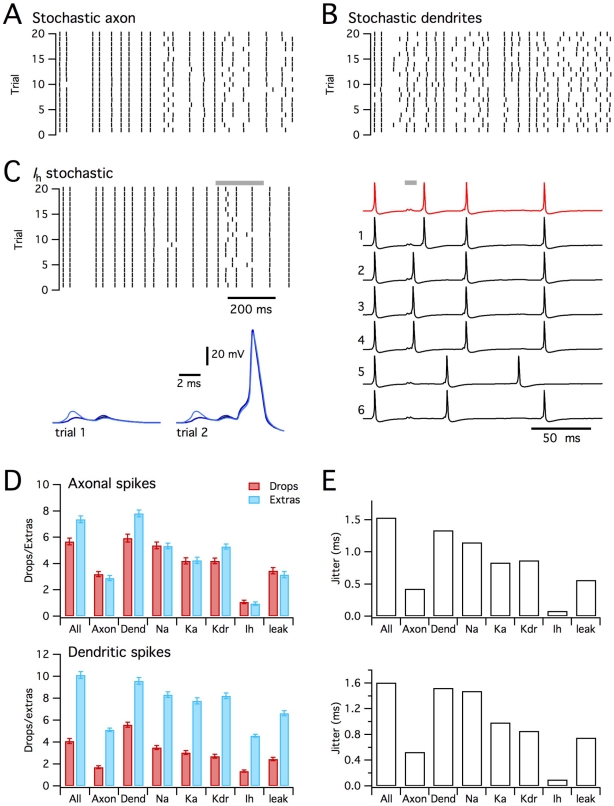
Differential impact of distinct ion channel types and locations.(A–B) Rasters for first 20 trials of responses of the CA1 pyramidal neuron simulated as in Figure 8, but with stochastic axonal and deterministic dendritic ion channels (A) or stochastic denritic and deterministic axonal ion channels (B). (C) as for (A–B), but only channels mediating I
h are stochastic. Shown are rasters (left), examples of membrane potential responses of the fully deterministic model (red) and first six sweeps recorded from the stochastic model (black), and examples of membrane potential waveforms corresponding to an “extra” action potential triggered by an additional dendritic depolarization. (D) Number of “dropped” and “extra” axonal spikes (top) and dendritic spikes (bottom) during 1s of simulated time for each experimental condition tested. Because of their all or nothing nature, large dendritic depolariations are classified as spikes. ANOVA indicated a significant (p<<1e-9) effect of model configuration on “dropped” and “extra” axonal and dendritic spikes. Key post-hoc comparisons are referred to in the main text. (E) Jitter in the timing of axonal (top) and dendritic (bottom) action potentials for each experimental condition.